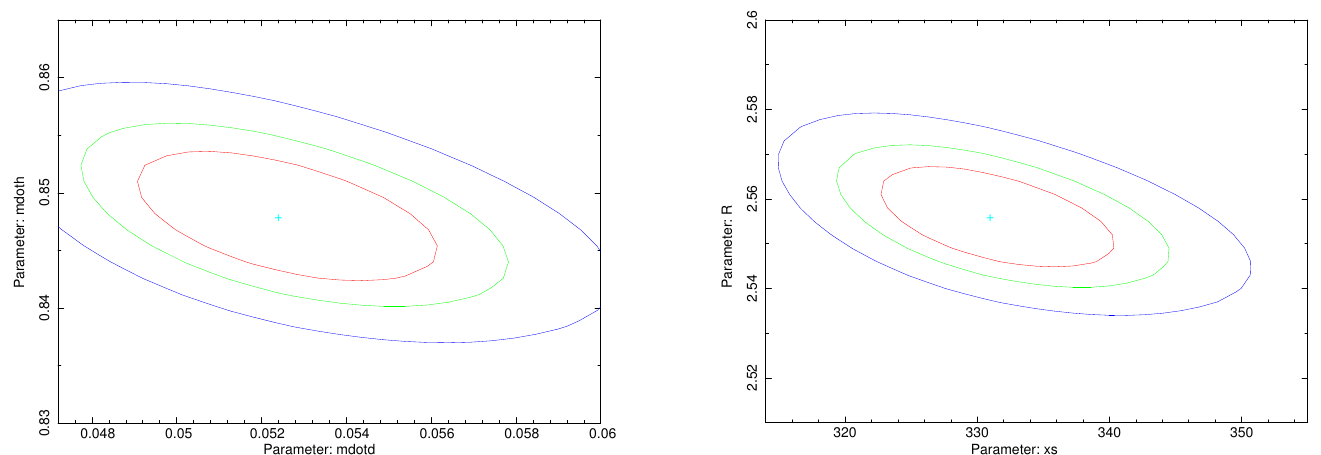
. . m d m h in the left panel and X s ˙ m h in the left panel and X s d − ˙ m h in the left panel and X s − R in the right panel. − −